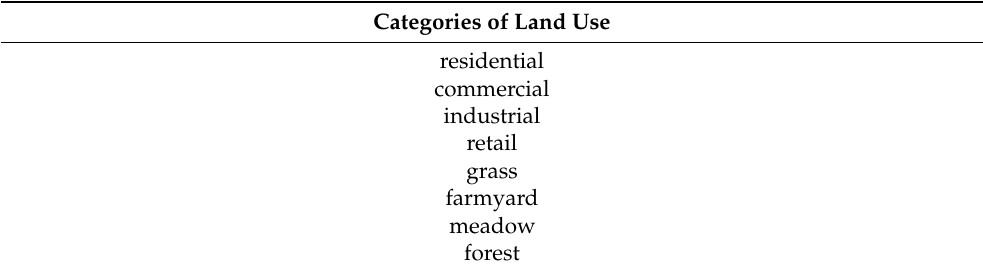
Table 1. List of the types of land use from the database www.osmlanduse.org (accessed on: 8 April